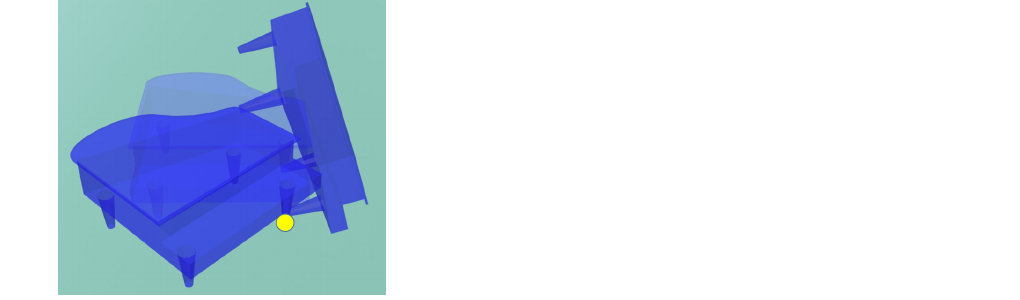
Figure 7. Sampling new object configurations through pivoting and tumbling at one object vertex.